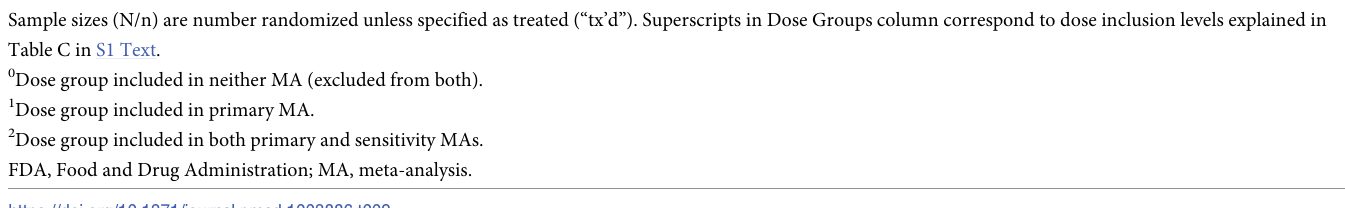
Table C in S1 Text. 0 Dose group included in neither MA (excluded from both). 1 Dose group included in primary MA. 2 Dose group included in both primary and sensitivity MAs. FDA, Food and Drug Administration; MA, meta-analysis.